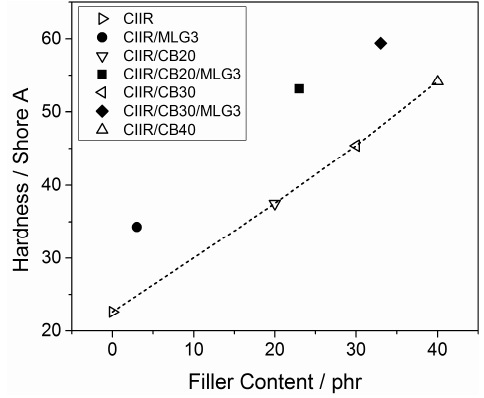
Figure 11. Hardness of CIIR and its composites as a function of the filler content; the line is a visual guide. Table 4. Mechanical properties of CIIR and its composites.